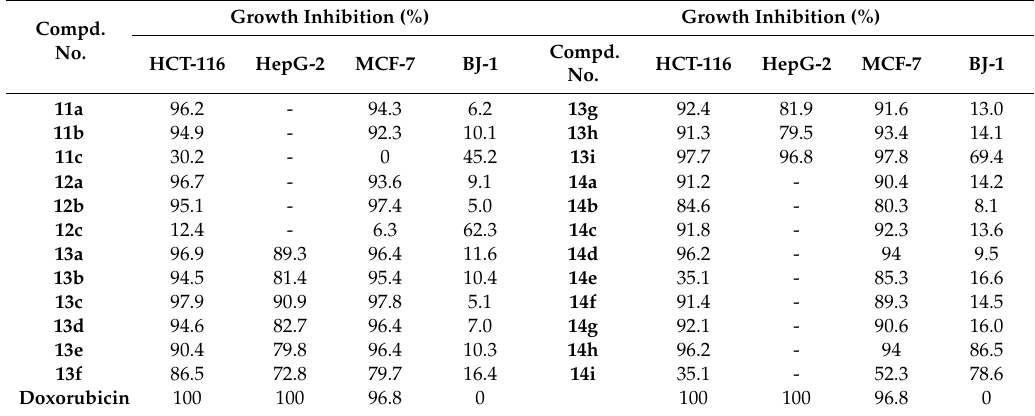
Table 3. Antiproliferative activity of the newly synthesized compounds against human carcinoma cell lines and normal skin fibroblast cells (BJ-1) at 100 µ g / ml. Compd. No.